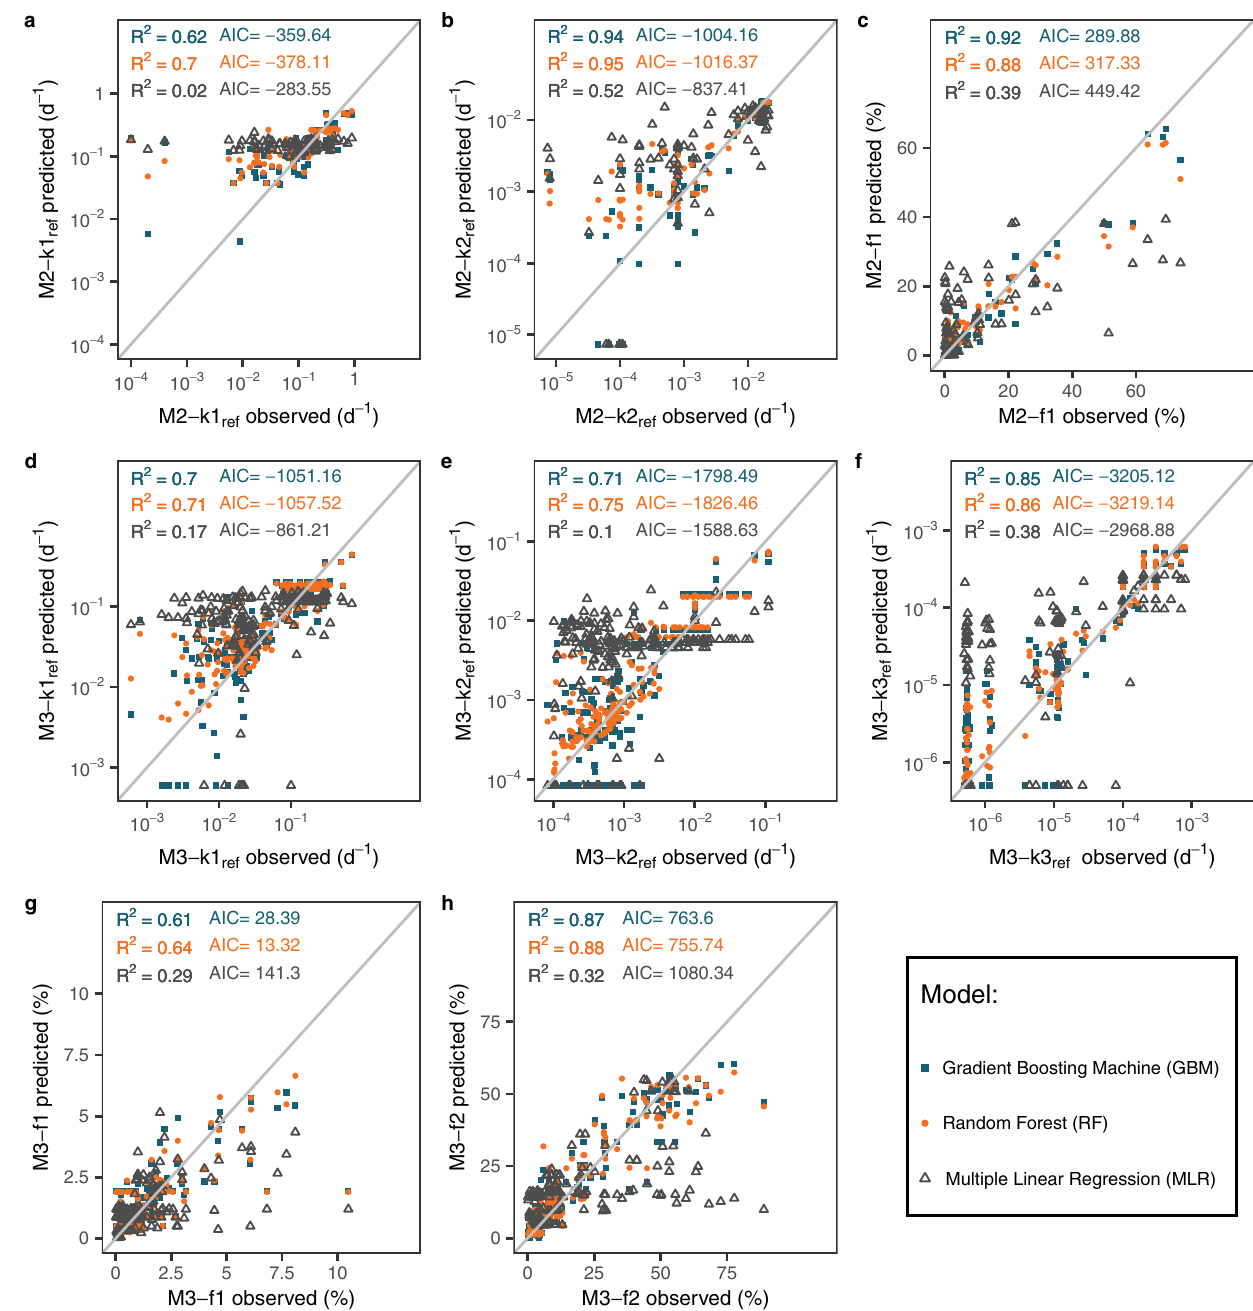
Fig. 2 | Modeling performance of the Gradient Boosting Machine (GBM), the Random Forest (RF), and the Multiple Linear Regression (MLR) with feature selection. a , b Reference decomposition rate of the fast (M2-k1 ref ) and slow pool (M2-k2 ref )inthetwo-poolmodel(M2). c ,Relativesizeofthefastpool(M2-f1)inthe two-pool model. d , e , f Reference decomposition rate of the fast (M3-k1 ref ), slow